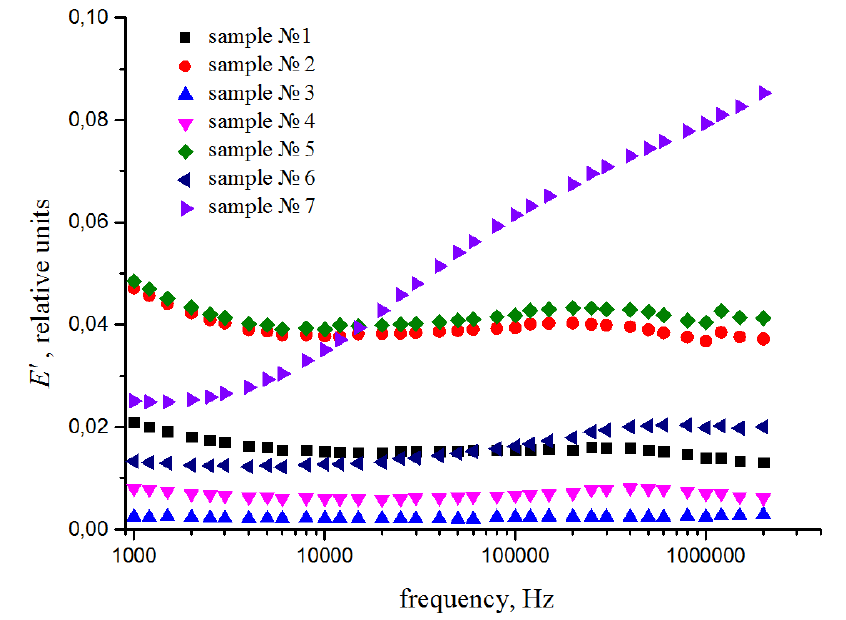
Fig. 2. Spectra of the imaginary part of the dielectric constant of the studied samples. Table 1. Values of the real part of the dielectric constant of the studied samples.